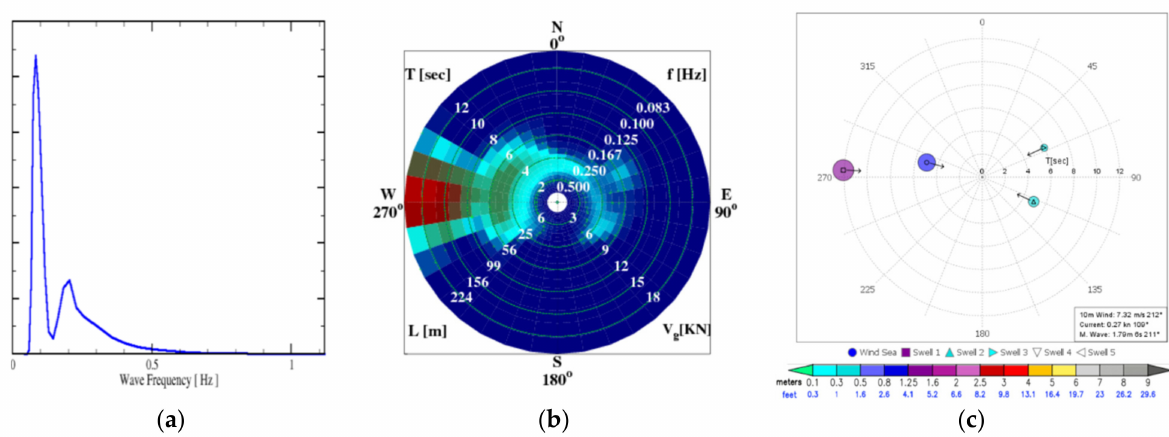
Figure 3. Different views of the same wave spectrum computed by WW3 model in proximity of the Capo Gallo RON buoy, for 03/10/2020 at 18:00 UTC. ( a ) One dimensional frequency spectrum. ( b ) Directional wave spectrum. ( c ) Corresponding wave partitions polar